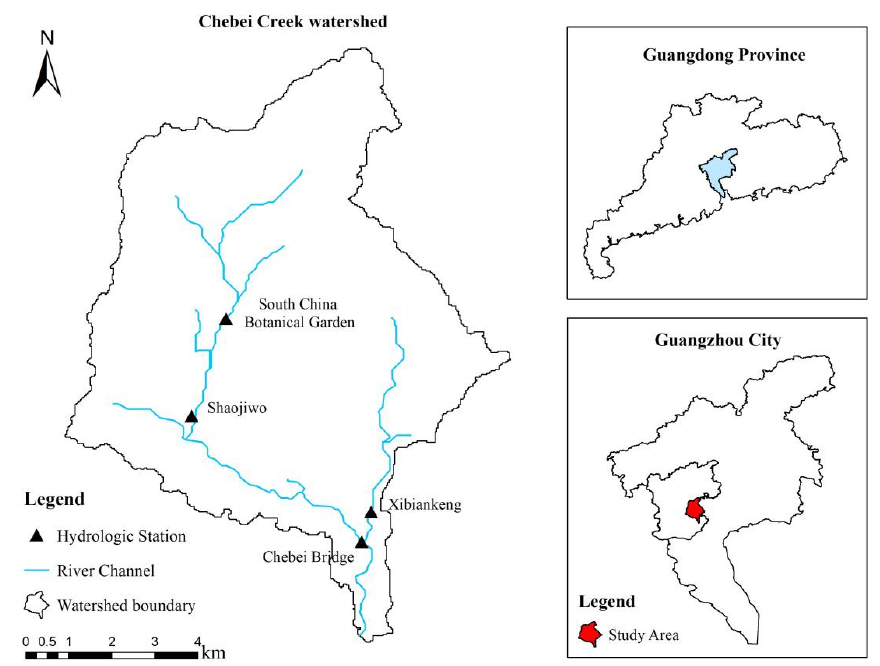
Figure 2. Location and map of the Chebei Creek watershed.